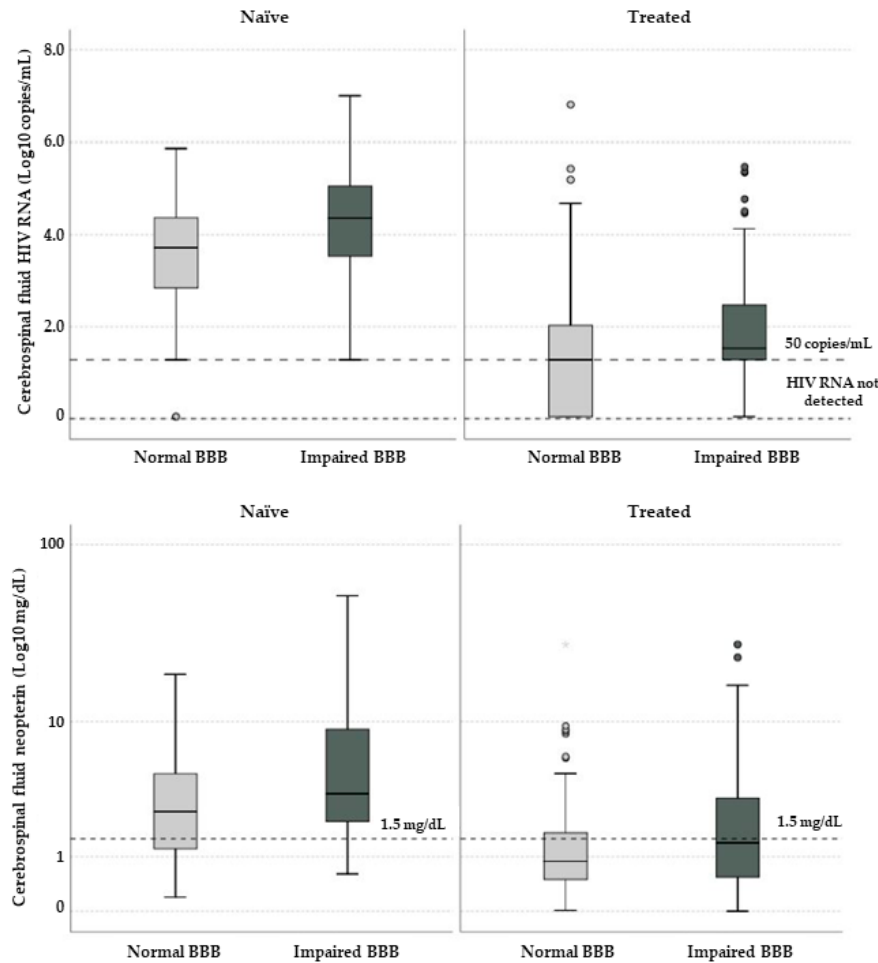
Figure 3. Cerebrospinal fluid HIV RNA ( above ) and neopterin ( below ) in study participants according to blood–brain barrier integrity and treatment status. Horizontal lines and boxes represent median values and interquartile ranges; whiskers show 10th and 90th percentiles while circles and stars are outliers and extreme outliers. In the graph above dotted horizontal lines represent 50 copies/mL and “target not detected” values; in the one below the horizontal dotted line represents the proposed threshold for cerebrospinal fluid neopterin (1.5